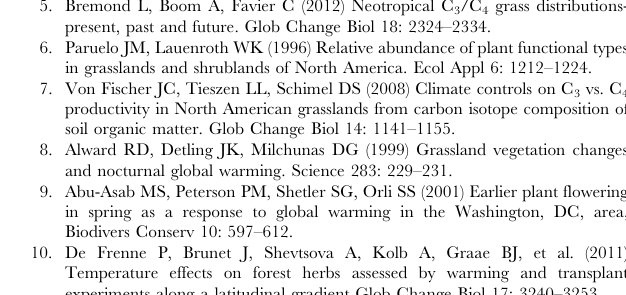
Figure S1 Final germination percentages of six species under different alternating temperature regimes (TmaxC, a, b; TaveC, c, d; AW, e, f; SW, g, h). C 4 species: a, c, e, g; C 3 species: b, d, f, h. Figure S2 Germination rates of six species under different alternating temperature regimes. See S1 for